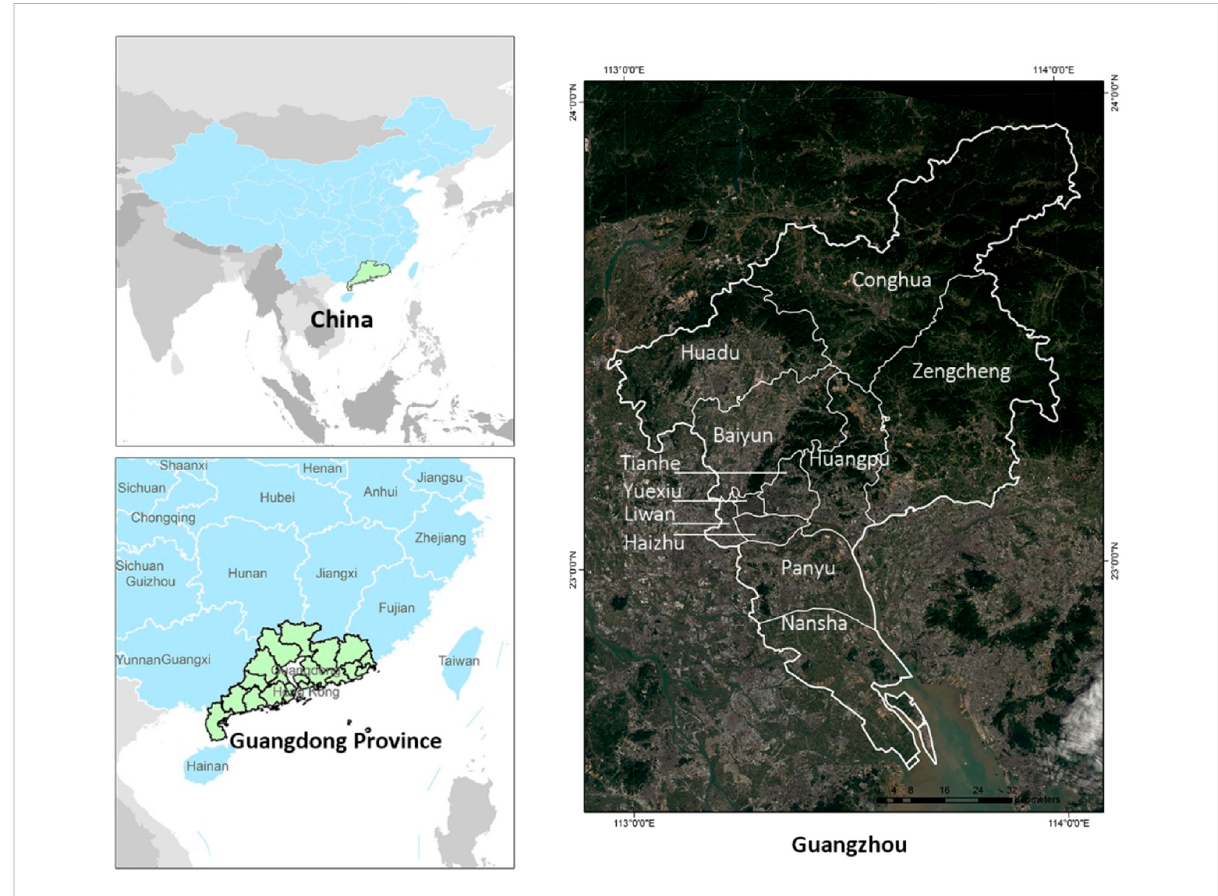
FIGURE 1 Guangzhou location